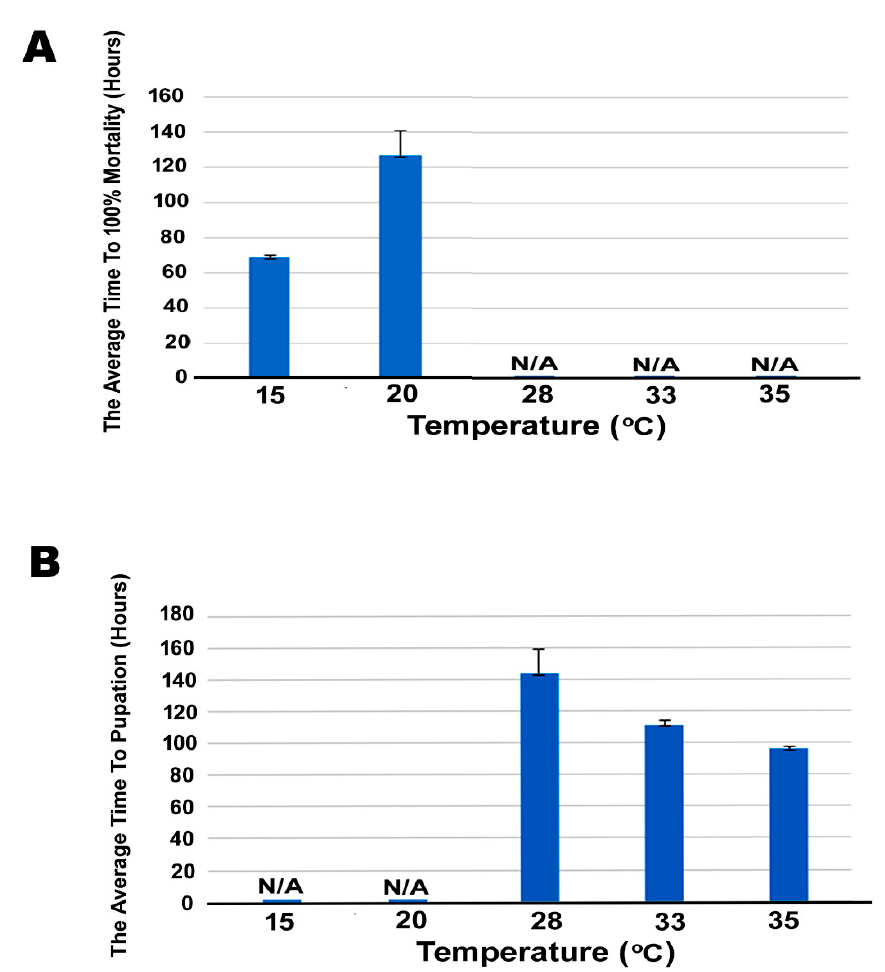
Figure 5. The effect of low temperatures on larvae development and metamorphosis. ( A) . The average time (h) that larvae reached to 100% mortality at different temperatures (15°C, 20°C, 28°C, 33°C, or 35°C ). N/A (Not Applicable) ( B ) The average time (h) that 5 th instar larvae reached to pupation at different temperatures (15 ◦ C, 20 ◦ C, 28 ◦ C, 33 ◦ C, or 35 ◦ C). N/A (Not Applicable).